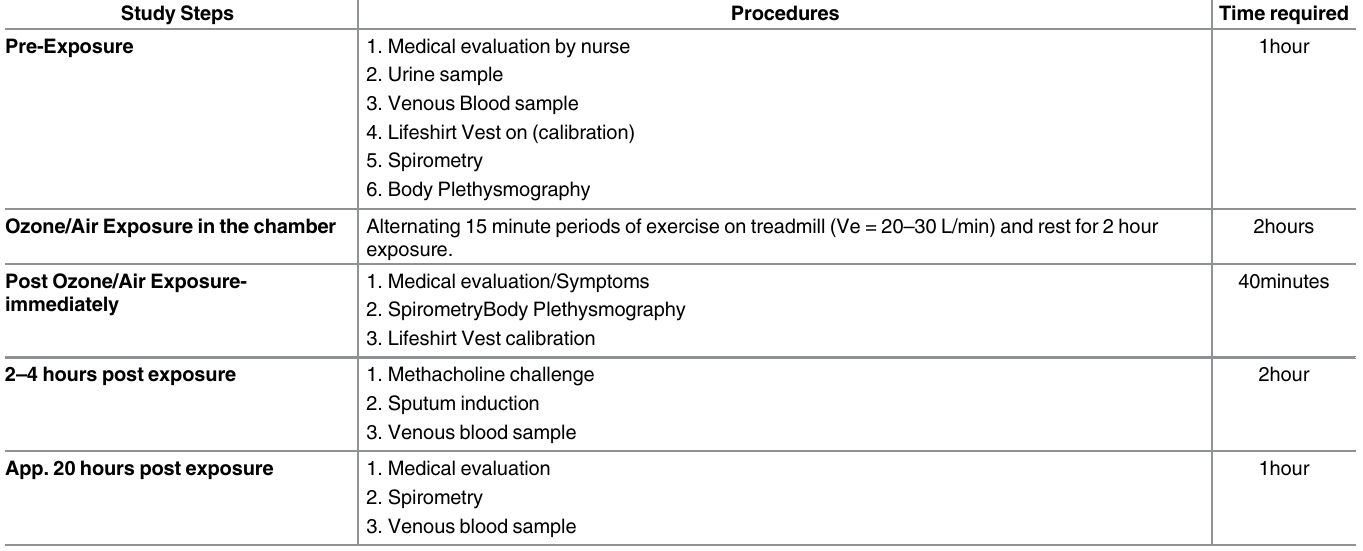
Table 1. Study Design Timeline (Exposure